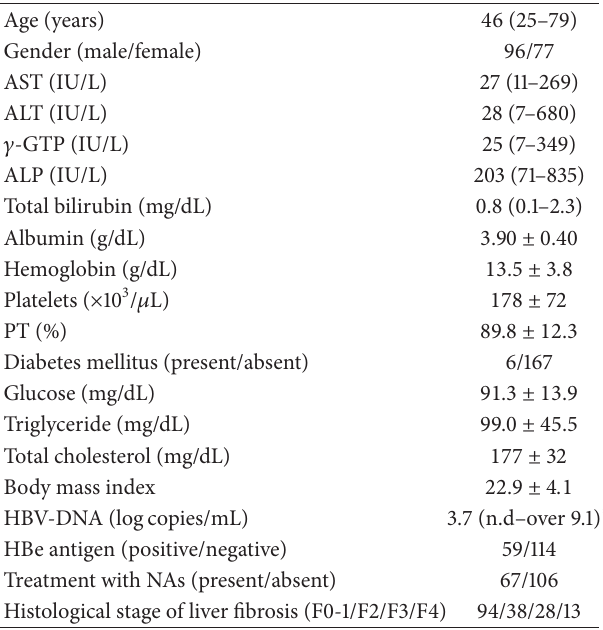
Table 1: The characteristics of the 173 hepatitis B virus- (HBV-) positive